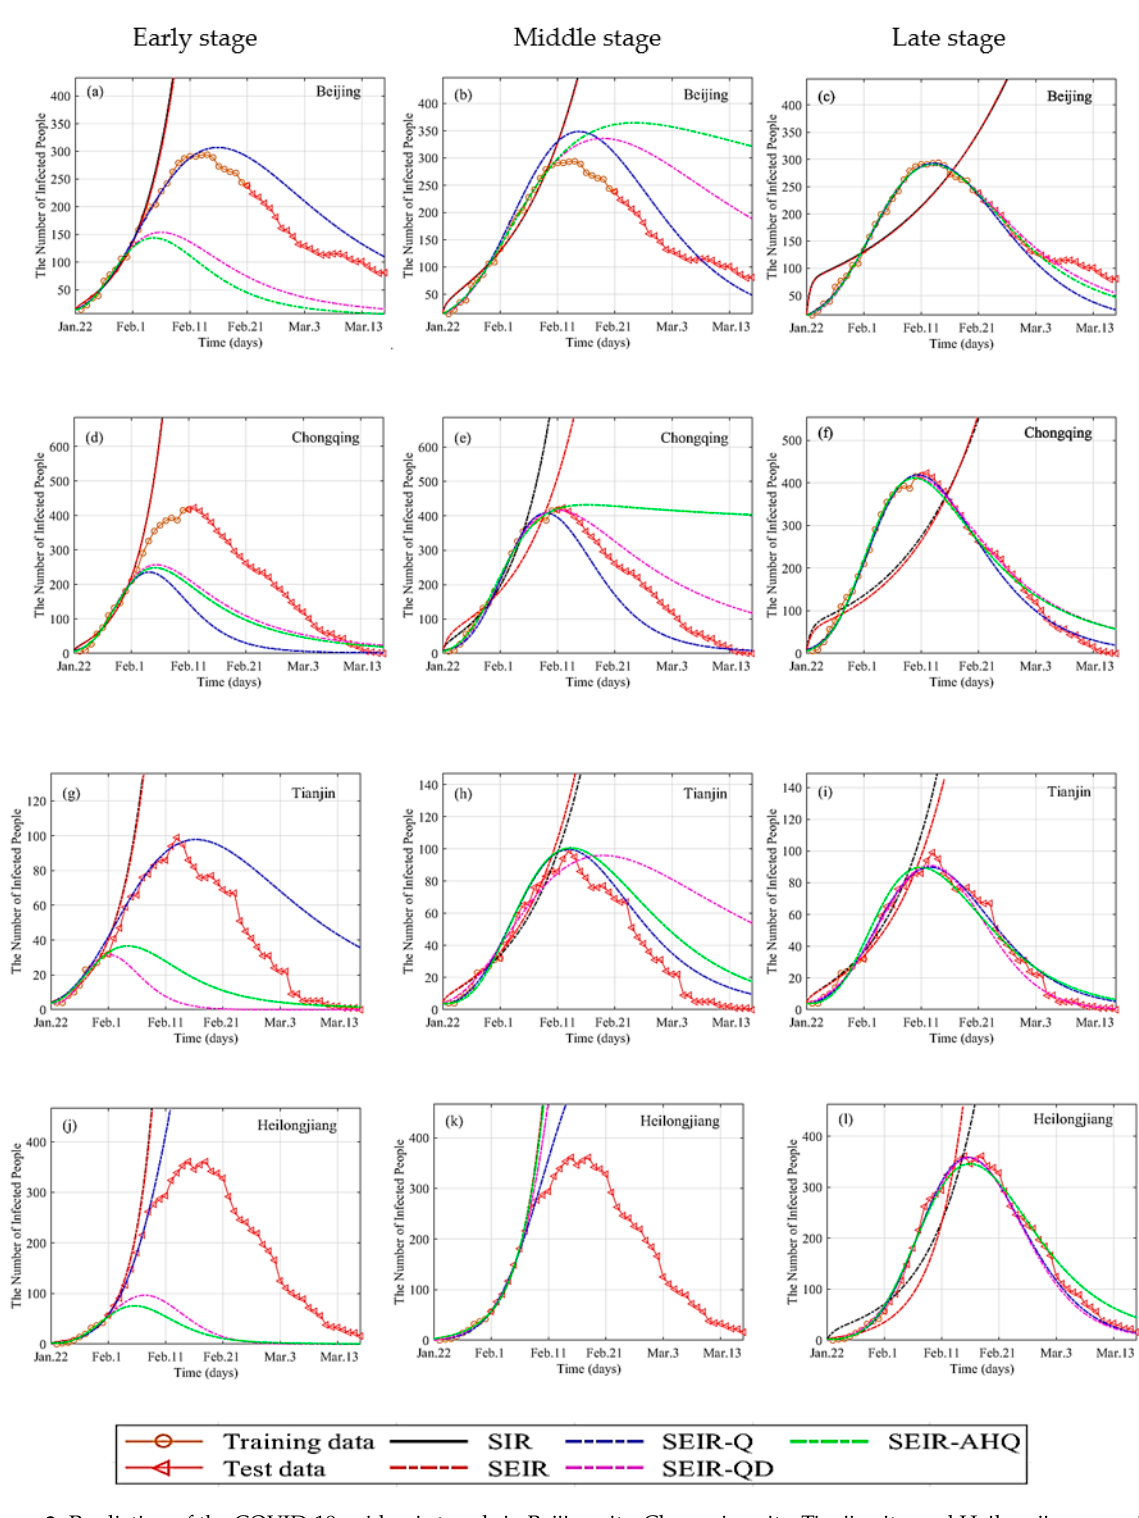
Figure 3. Prediction of the COVID-19 epidemic trends in Beijing city, Chongqing city, Tianjin city, and Heilongjiang province from 22 January 2020 to 5 March 2020 based on the data of first 10 (early stage), 20 (middle stage), and 30 (late stage) days, respectively. ( a – c ) The number of infected people in Beijing at different stages; ( d – f ) The number of infected people in Chongqing at different stages; ( g – i ) The number of infected people in Tianjin at different stages; ( j – l ) The number of infected people in Heilongjiang at different stages.